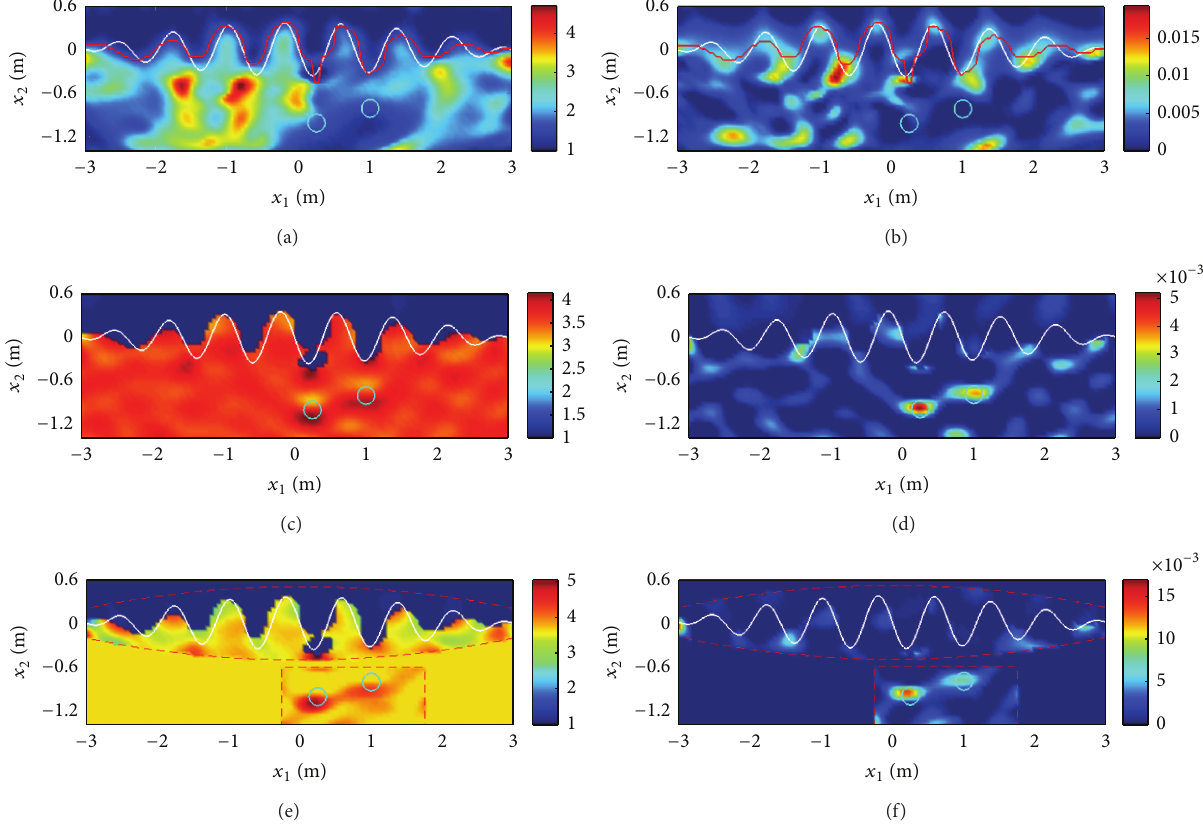
Figure 9: (a) Reconstructed permittivity and (b) conductivity profiles and the determination of the rough surface after the first stage. Final results of permittivity and conductivity profiles ((c)-(d)) for the entire domain and ((e)-(f)) for the narrowed